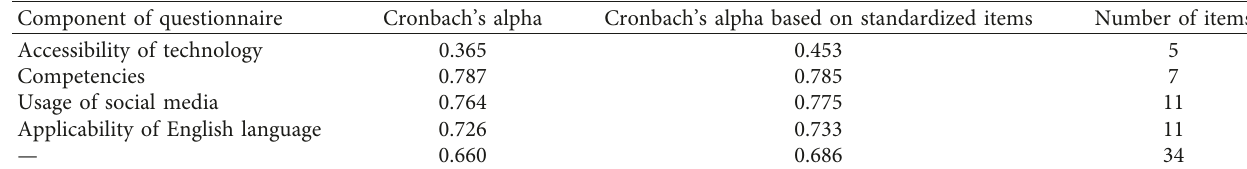
Table 1: Reliability statistics